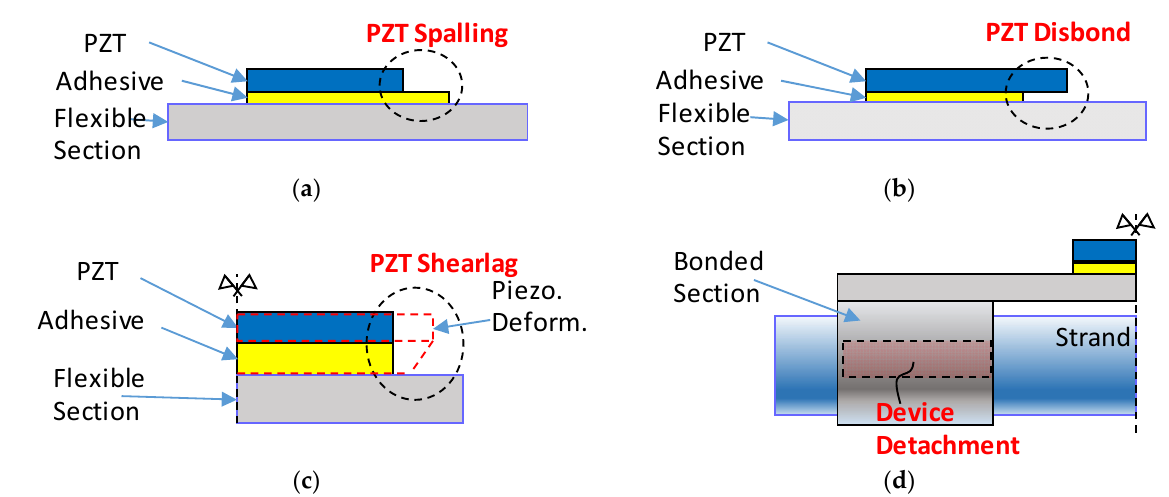
Figure 3. Illustration of potential failures in the smart strand. ( a ) Transducer breakage; ( b ) Transducer disbond; ( c ) Shear ‐ lag; ( d ) Device detachment.